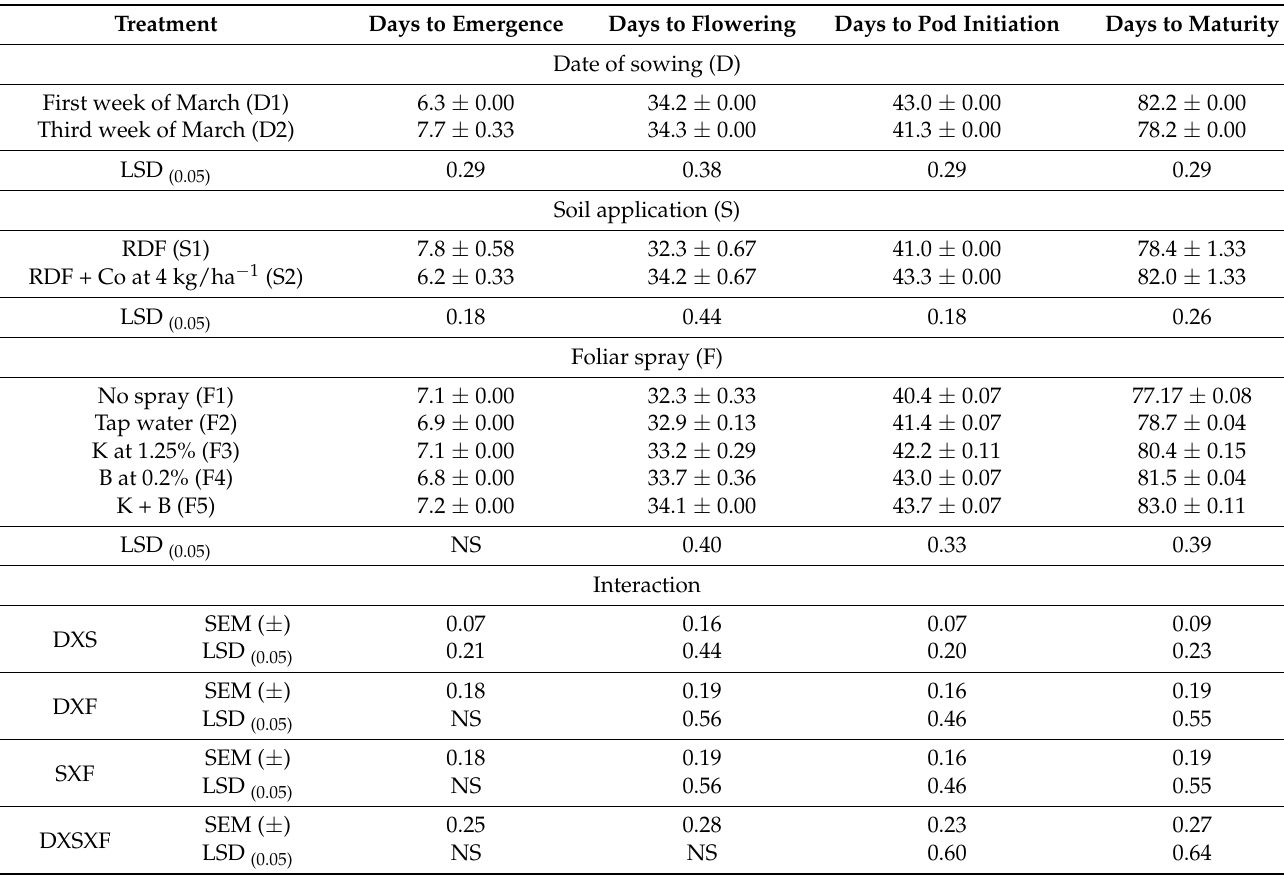
Table 6. Factor-wise effect of the date of sowing, soil application of Co, and foliar spray with K and B on the phenology of black gram during the spring–summer season (pooled over two years). Treatment Days to Emergence Days to Flowering Days to Pod Initiation Days to